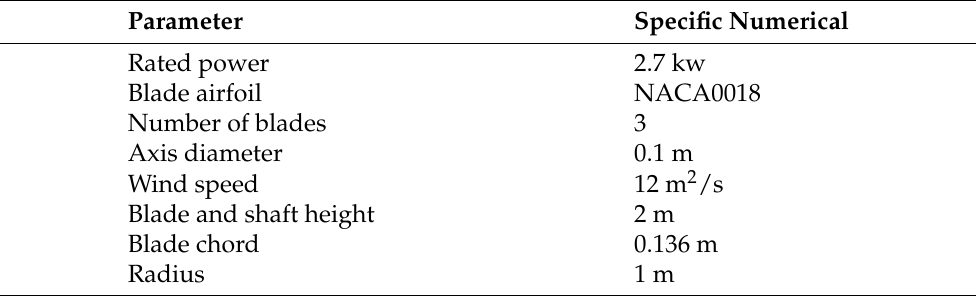
Table 2. Wind generator